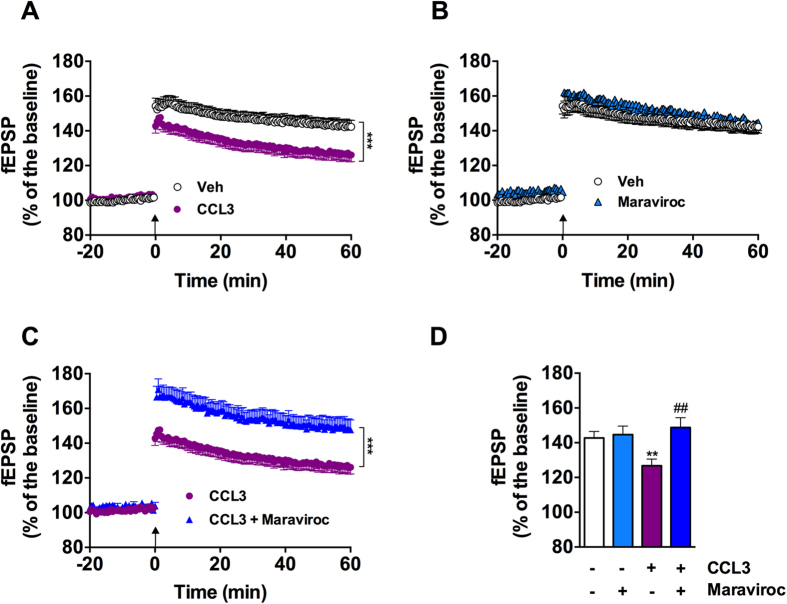
CCL3 decreases hippocampal long-term potentiation expression via an effect on CCR5 receptors.(A) CCL3 treatment (50 ng/mL) induces a significant decrease of the LTP induced by 4 trains at high frequency, symbolized by the arrow (control vehicle condition, n = 31; CCL3 treatment, n = 16; ***p < 0.001 vs. Vehicle, Two-way ANOVA). (B) Maraviroc (15 nM), a CCR5 antagonist does not affect LTP (control vehicle condition, n = 31; maraviroc, n = 11; p > 0.05 vs. Vehicle, Two-Way ANOVA). (C) Co-treatment with CCL3 (50 ng/mL) and Maraviroc (15 nM) prevents CCL3 effects on LTP expression (n = 16, ***p < 0.001 vs. CCL3 alone, Two-way ANOVA). In order to normalized the pre-LTP or pre-LTD signal between different conditions, an I/V curve was realized before baseline recording to adjust the intensity of the stimulus of each experiment to elicit a fEPSP of 35% of the maximum. This intensity was kept constant throughout the CCL3 application. (D) Representative histograms of fEPSP variation during the last five minutes in the different experimental conditions (**p < 0.01 vs. Vehicle, ##p < 0.01 vs. CCL3 alone using One-Way ANOVA followed by a LSD Fisher post-hoc test).